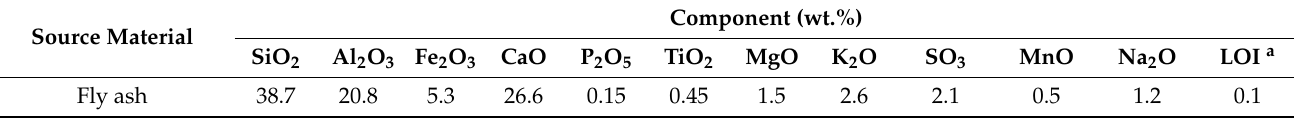
Table 5. Chemical composition of high calcium fly ash.